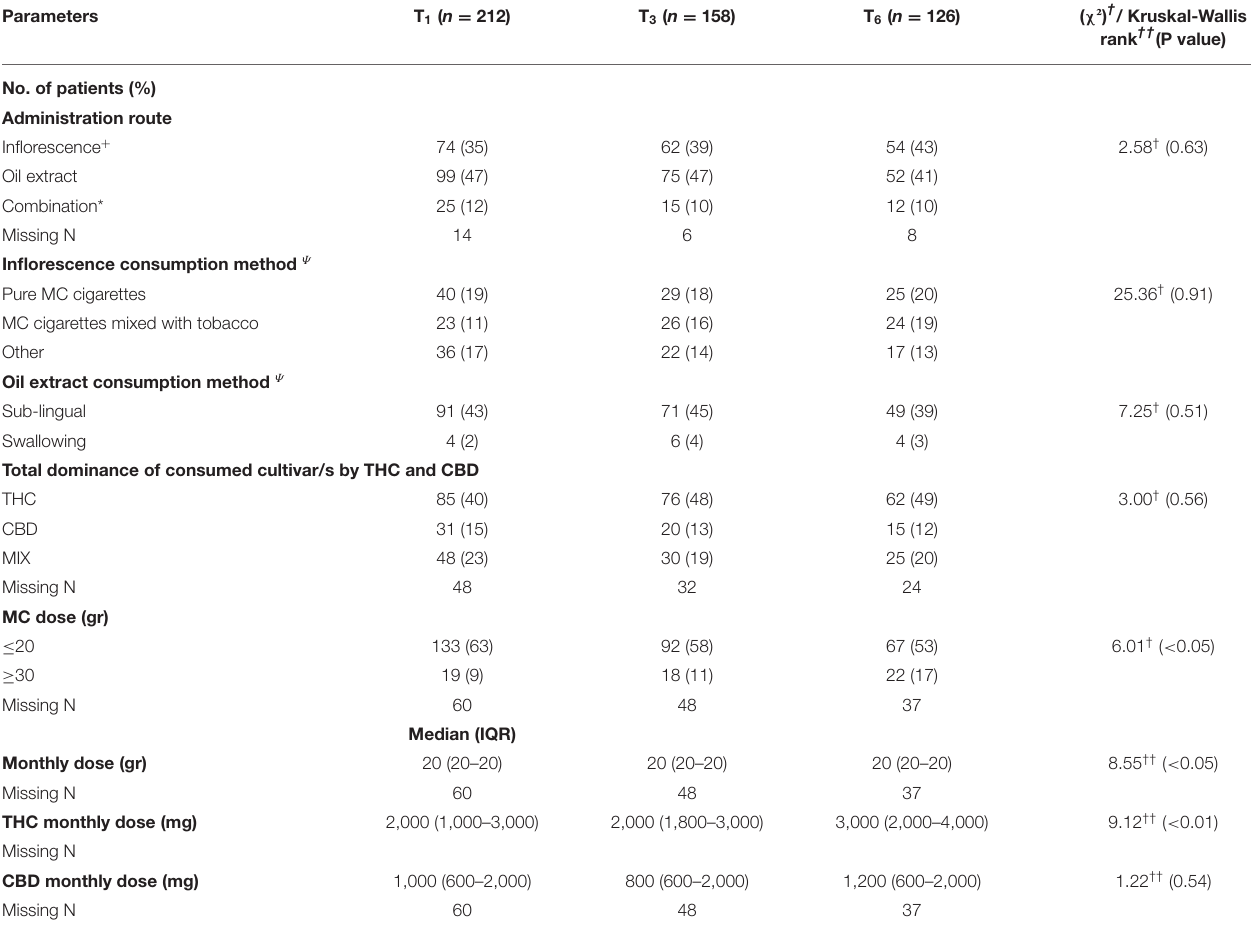
TABLE 2 | Medical cannabis treatment characteristics.